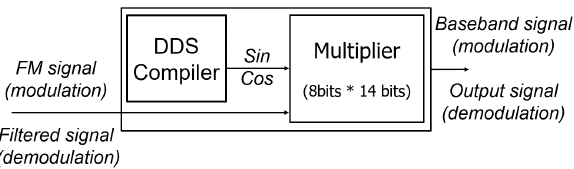
Figure 4. Block diagram of the digital